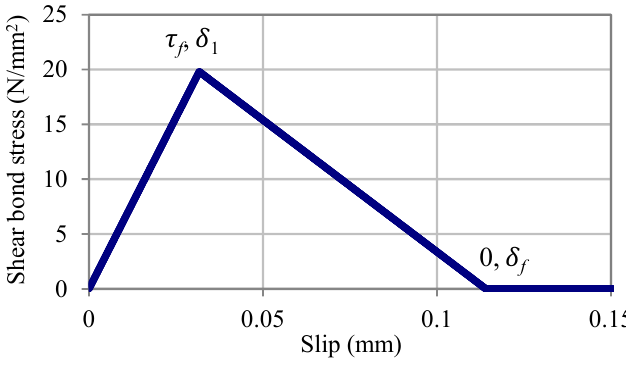
Figure 19. Shear bond-slip model for bonded CFRP-steel